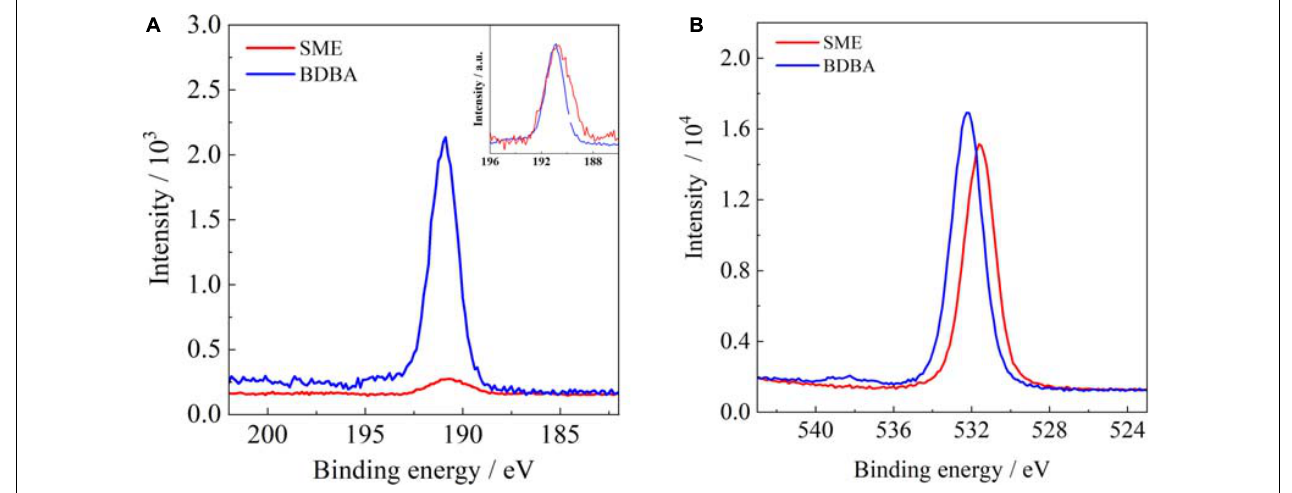
FIGURE 4 | XPS spectra of (A) B 1s and (B) O 1s core level binding energies in BDBA and SME.